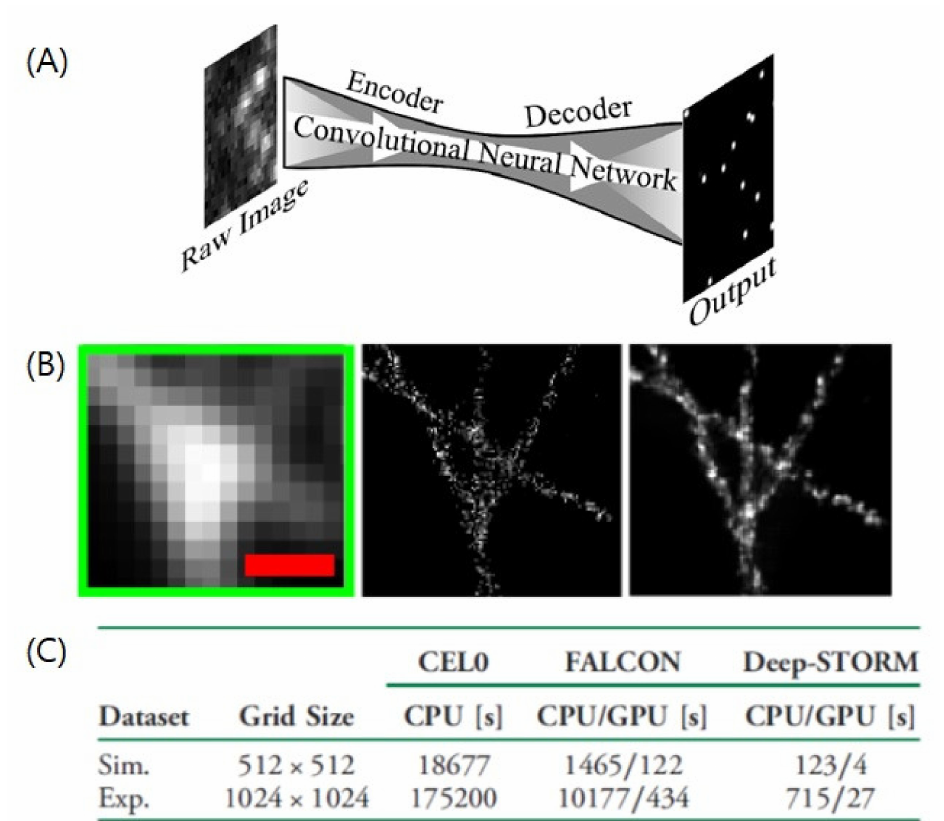
Figure 4. A deep-learning-based method for the fast single-molecule localization ( A ) Network ar- chitecture of Deep-STORM. A set of diffraction-limited images of blinking emitters is fed into the convolutional neural network to generate the final super-resolved image. ( B ) Experimental micro- tubule images. (Left) Diffraction-limited low resolution image. (Middle) Reconstructed image by the CEL0 method. (Right) Reconstructed image by Deep-STORM. Scale bar is 2 µ m. ( C ) Comparison of runtime between different methods. Adapted from the article of [31] under the OSA Open Access Publishing